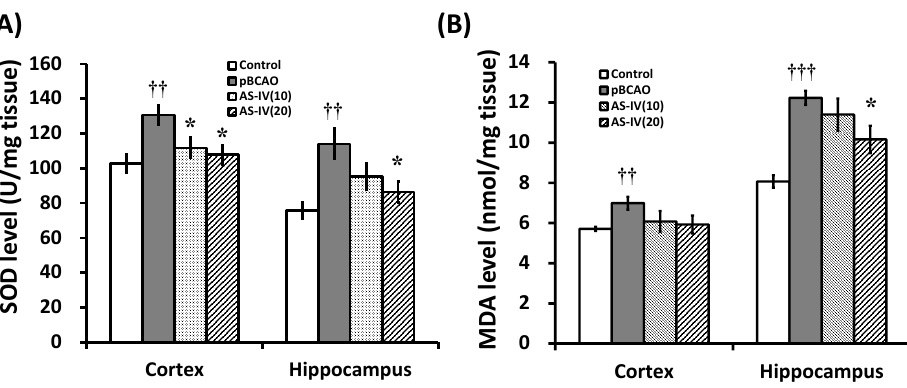
Figure 5. Effects of astragaloside IV (AS-IV) on the levels of SOD and MDA in brain tissue. AS-IV significantly reduced SOD levels in the cerebral cortex and the hippocampus at a dose of 20 mg/kg ( A ). AS-IV significantly attenuated the upregulation of MDA levels in the hippocampus at 20 mg/kg treatment ( B ). Data are presented as mean ± SEM ( n = 6 in each group; †† , p < 0.01; ††† , p < 0.001 between the control and the pBCAO groups; * , p < 0.05 between the pBCAO and AS-IV